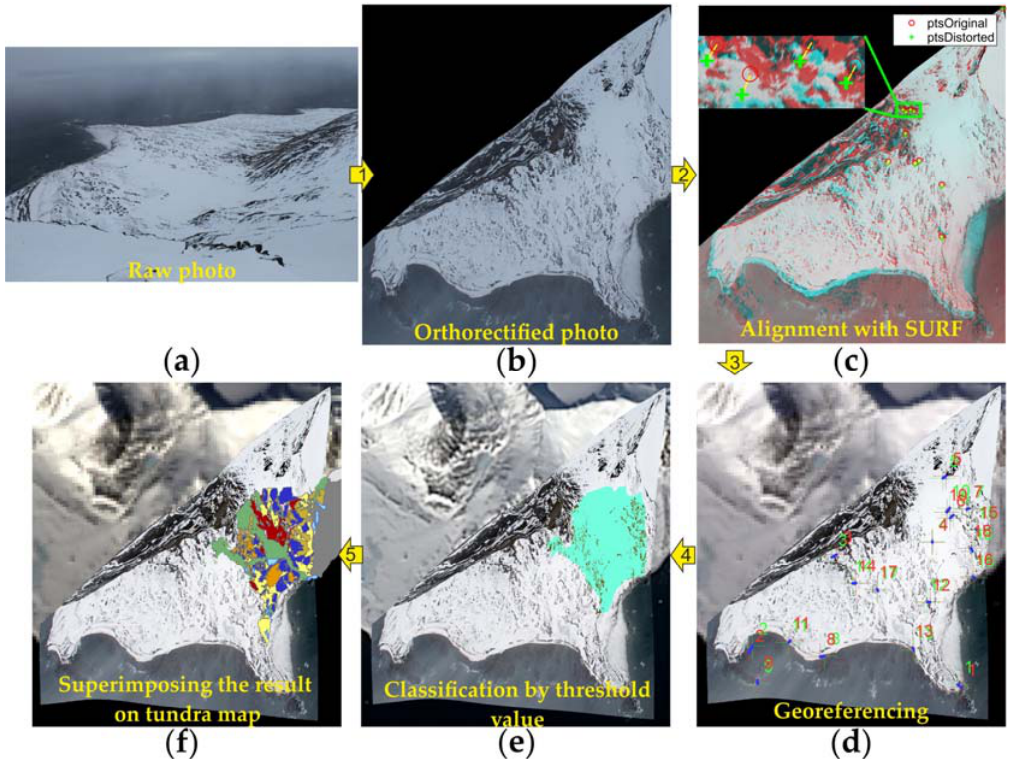
Figure 3. Workflow for the images obtained from the time-lapse camera on the example of picture from 4 May 2016: ( a ) raw photo from the camera; ( b ) picture after the orthorectification process; ( c ) picture superimposed on reference scene. Marked characteristic terrain features recognized on both pictures by SURF algorithm (“ptsOriginal”—features on the reference scene; “ptsDistorted”—the same features identified on the input image (4 May 2016)) and used in alignment process compensating the camera movements; ( d ) picture embedded in geographical space (Landsat 8 scene from 28 April 2016 in the background) with marked GCPs used in georeferencing process; ( e ) Results of pixel classification into snow/snow-free surfaces using threshold value in blue band, clipped to the study area; ( f ) processed picture with superimposed the land cover map used in spatial analysis.